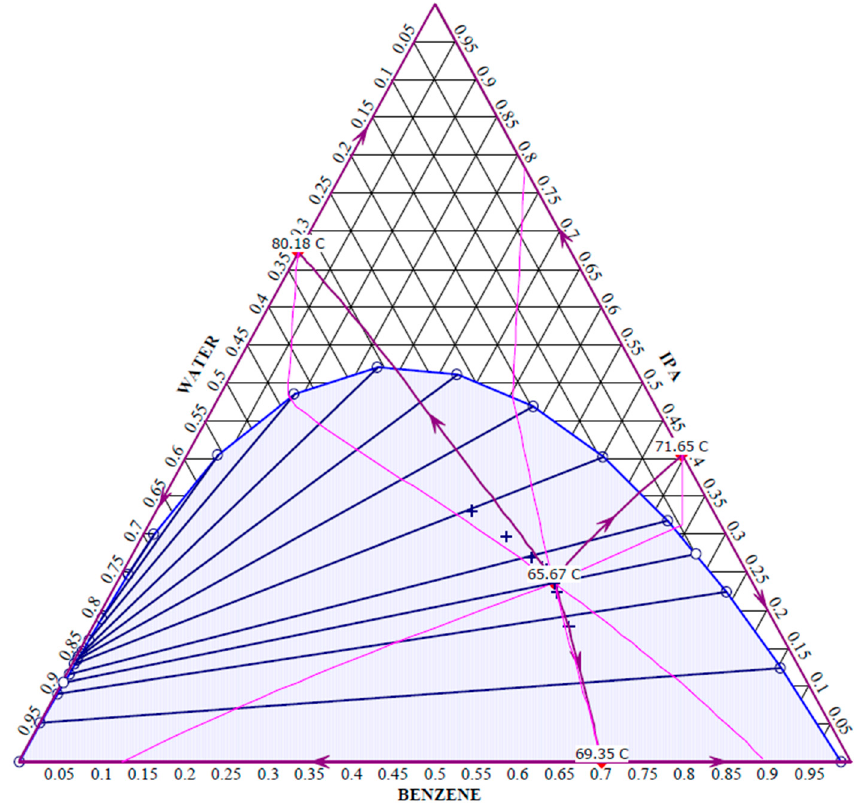
Figure 2. Ternary map at 1 atm, obtained by means of Aspen Plus ® V11 [61] using the NRTL model, for the system 2-propanol (IPA) + water (WATER) + benzene (BENZENE).